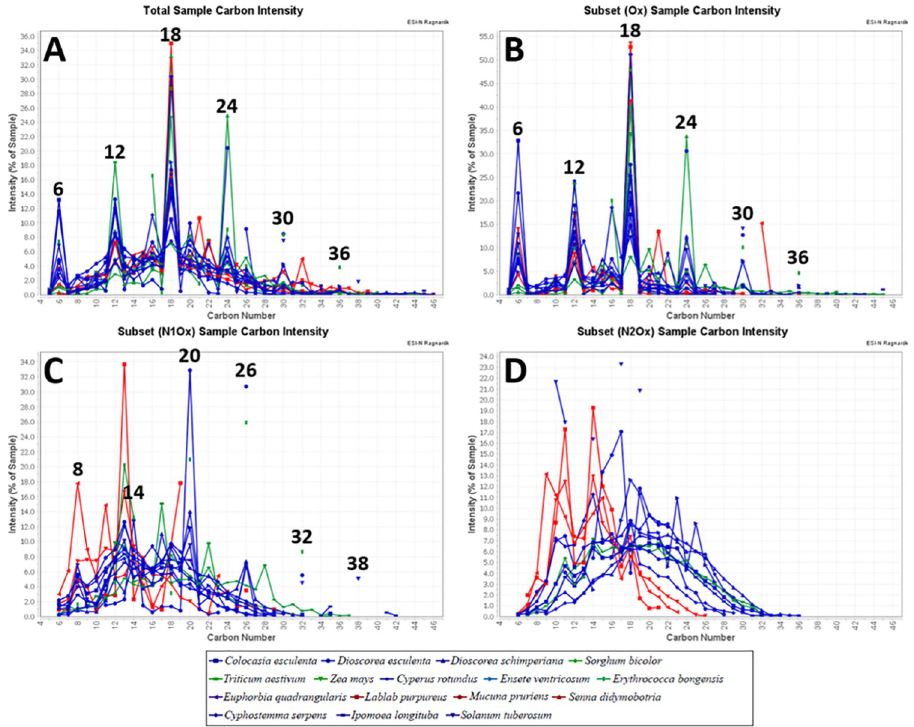
Fig 5. Consolidated carbon number distribution for all Maillard reaction products. A- Overall total carbon number distribution. B- Species containing only oxygen as heteroatom per molecule (Ox). C- Species containing one nitrogen and oxygen atoms (NOx). D- Species with two nitrogen and oxygen atoms (N2Ox). Most peaks reflect neo-formed, polysaccharide relics: A, B. Aditional two-carbon and one nitrogen may reflect simple polysaccharides plus single amino acid carbon skeletons (C). The predominance of species with incorporation of two glycine units into the newly formed molecules is less evident in (D).